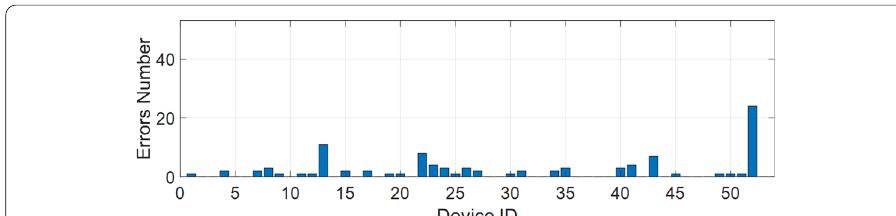
Fig. 20 The number of errors for rogue devices. The figure shows the number of errors that occurred when one device is selected as legal and the remaining 53 ones are selected as rogue devices in turn